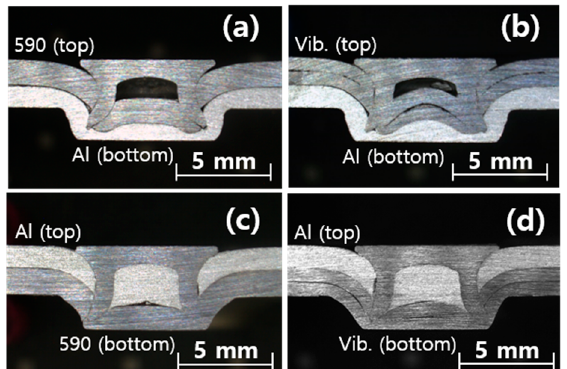
Figure 14. Comparison of cross-sectional images of SPR joint (fabricated by type A1 die) for different stack-up combinations. ( a ) SPFC590DP (top) and Al5052-H32 (bottom), ( b ) vibration-damping steel (top) and Al5052-H32 (bottom), ( c ) Al5052-H32 (top) and SPFC590DP (bottom), and ( d ) Al5052-H32 (top) and vibration-damping steel (bottom).